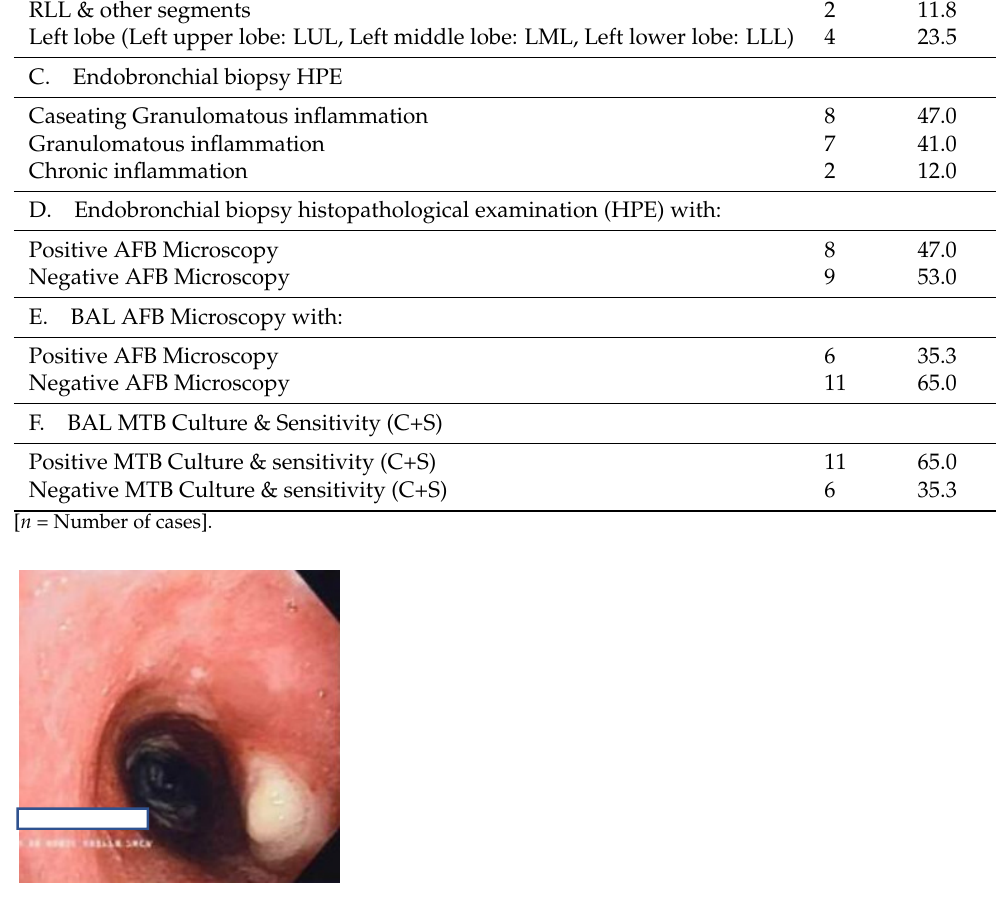
Figure 1. Caseating lesion. Type 1 Endobronchial TB.